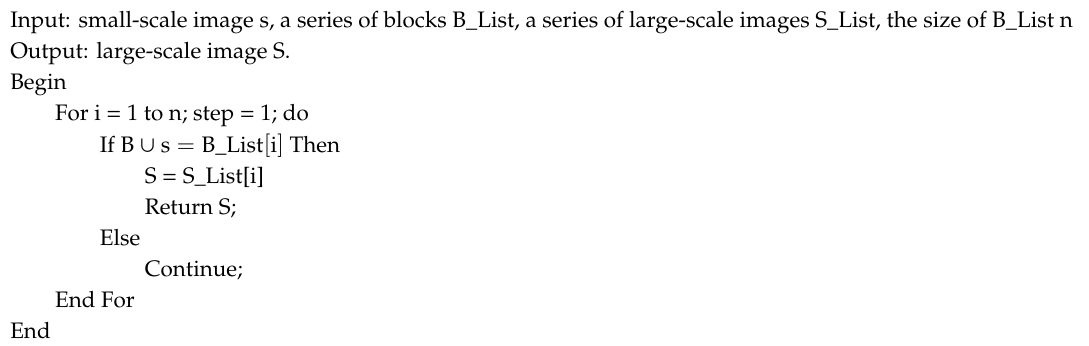
Algorithm 1 For matching small-scale images with large-scale images